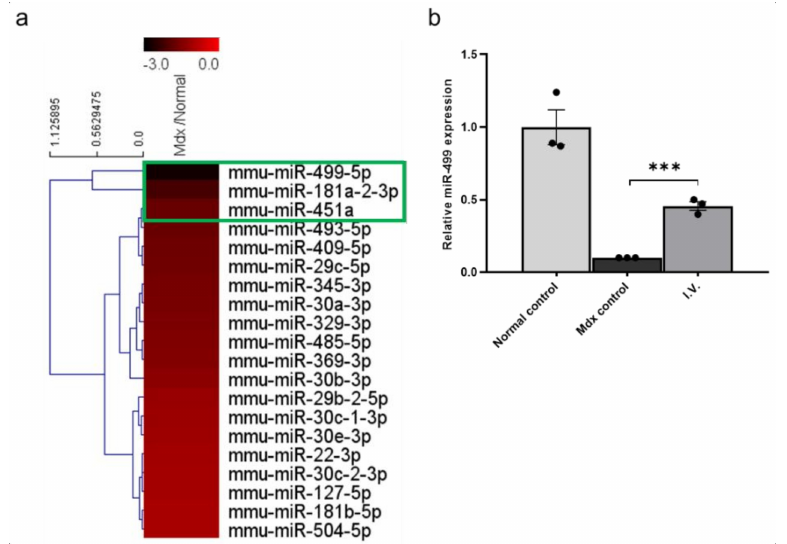
Figure 2. miR-499-5p is downregulated in mdx mice compared to healthy mice ( a ) Heatmap depicting the levels of miRNAs commonly expressed in humans and mice in mdx mice and healthy mice. ( b ) Relative miR-499-5p expression levels in the skeletal muscles of each group. miR-26a-5p was used as an endogenous control. The data are expressed as the mean ± SEM. Bars with different superscripts indicate significantly different (*** p <